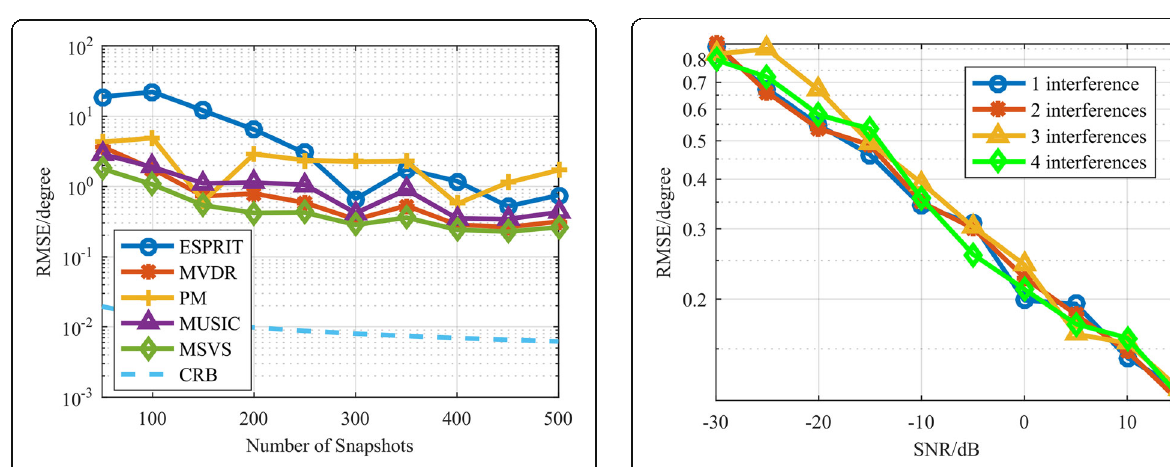
Fig. 8 RMSE with different interference number, N =